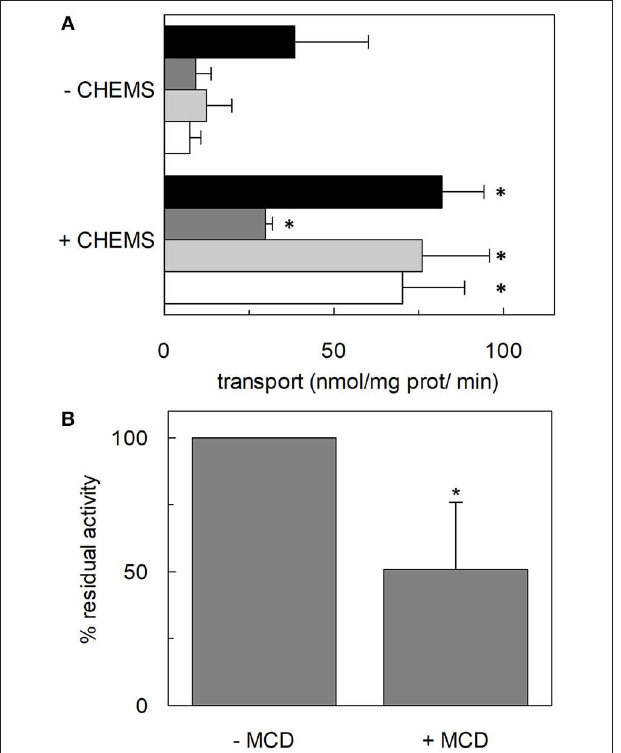
FIGURE 3 | Effect of cholesterol on transport activity mediated by hASCT2. In (A) , purified hASCT2 was reconstituted in proteoliposomes prepared without CHEMS or with 75 µ g/mg phospholipids CHEMS as indicated and described in Materials and Methods. Transport assay was started adding 50 µ M of [ 3 H]glutamine and 50mM Na-Gluconate to proteoliposomes containing 10mM glutamine (black bar) or asparagine (dark gray bar) or threonine (light gray bar) or serine (white bar). Initial transport rates were calculated as k x limit (nmol/mg prot/min) from the first-order rate equation used to plot the time course data. Data are means ± SD of three independent experiments. In (B) , HeLa cells were treated with 10mM methyl- β -cyclodextrin (MCD) as described in Materials and Methods. Transport was started adding 10 µ M [ 3 H]glutamine in the presence or in the absence of 100mM NaCl. Transport activity was calculated as the percent of residual activity with respect to the control condition (without MCD in the transport assay). *Significantly different from the control sample (proteoliposomes prepared without CHEMS in A or without MCD in B ) as estimated by Student’s t-test ( P <